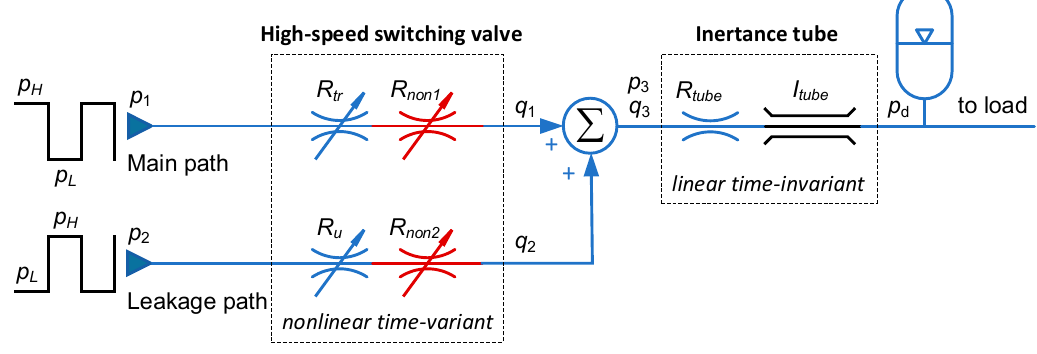
Figure 2. Schematic of enhanced analytical model of a three-port flow booster [11].